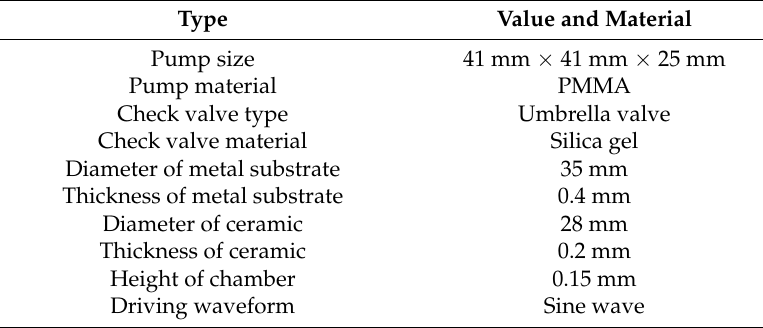
Table 1. Parameters of